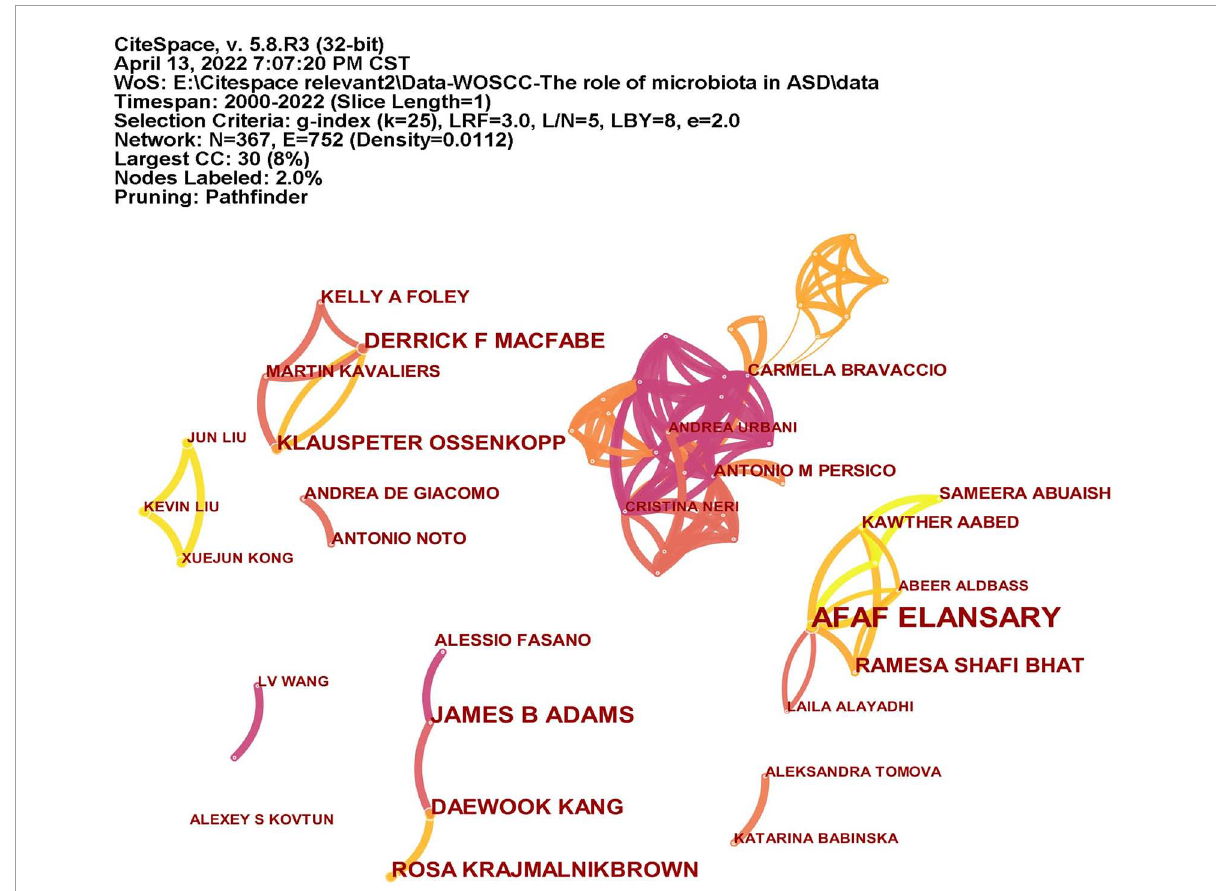
FIGURE5 The network of authors publications and collaborations. The size of the letters represents the number of publications and the lines represent collaborations. The larger the letter is, the greater the number of publications. Thicker lines indicate closer